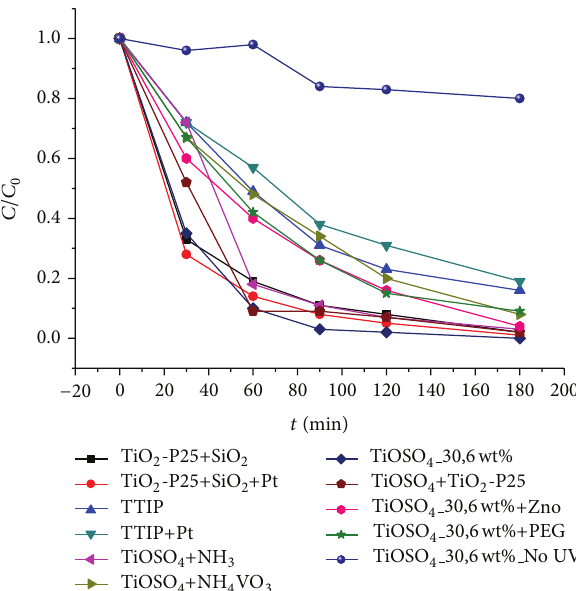
Figure 9: Change in concentration of MB with time. MB initial concentration: 14mg/L, UV radiation 𝜆 > 280 nm–420 nm, recir- culating reactor open to air, absorption at 665 nm and immobilized